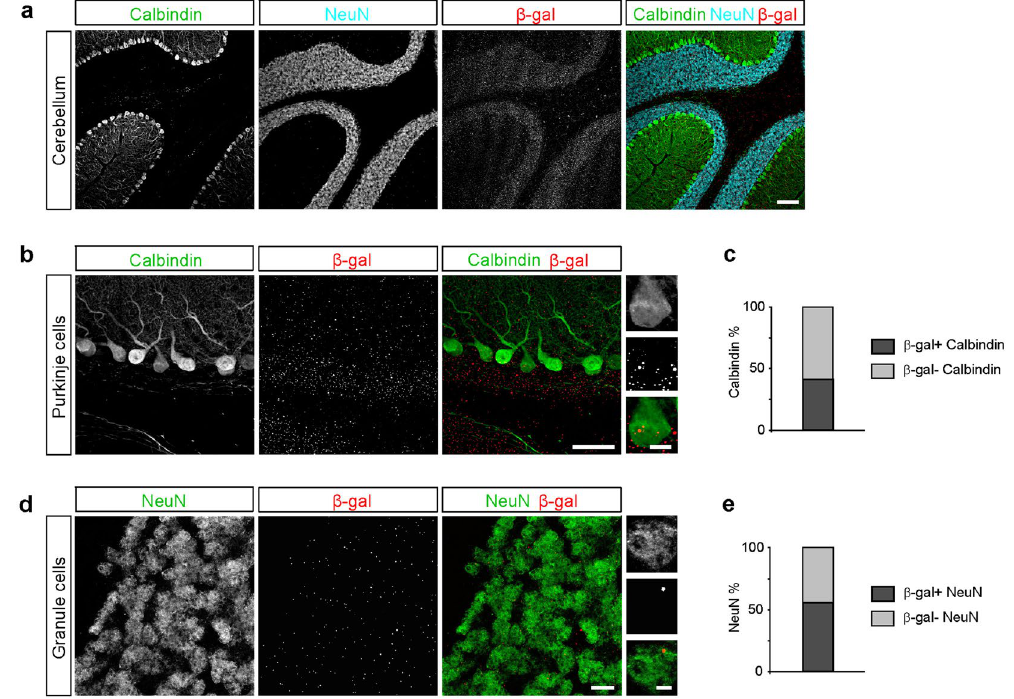
Figure 4. C9orf72 promoter activity in Purkinje cells and granule cells of the cerebellum. ( a ) Representative images of the cerebellum showing calbindin-positive Purkinje cells (green), NeuN-positive granule cells (cyan), and β -gal staining (red). Scale bar: 100 μ m. ( b ) Representative images of calbindin-positive Purkinje cells (green) and β -gal (red). Scale bars: 50 μ m and 10 μ m. ( c ) The percentage of Purkinje cells containing β -gal puncta (35 of 85 cells, 41.2%, n = 3 mice). ( d ) Representative images of NeuN-positive granule cells (green) and β -gal (red). Scale bars: 10 μ m and 2 μ m. ( e ) The percentage of granule cells containing β -gal puncta: (306 of 548 cells, 55.8%; n = 3